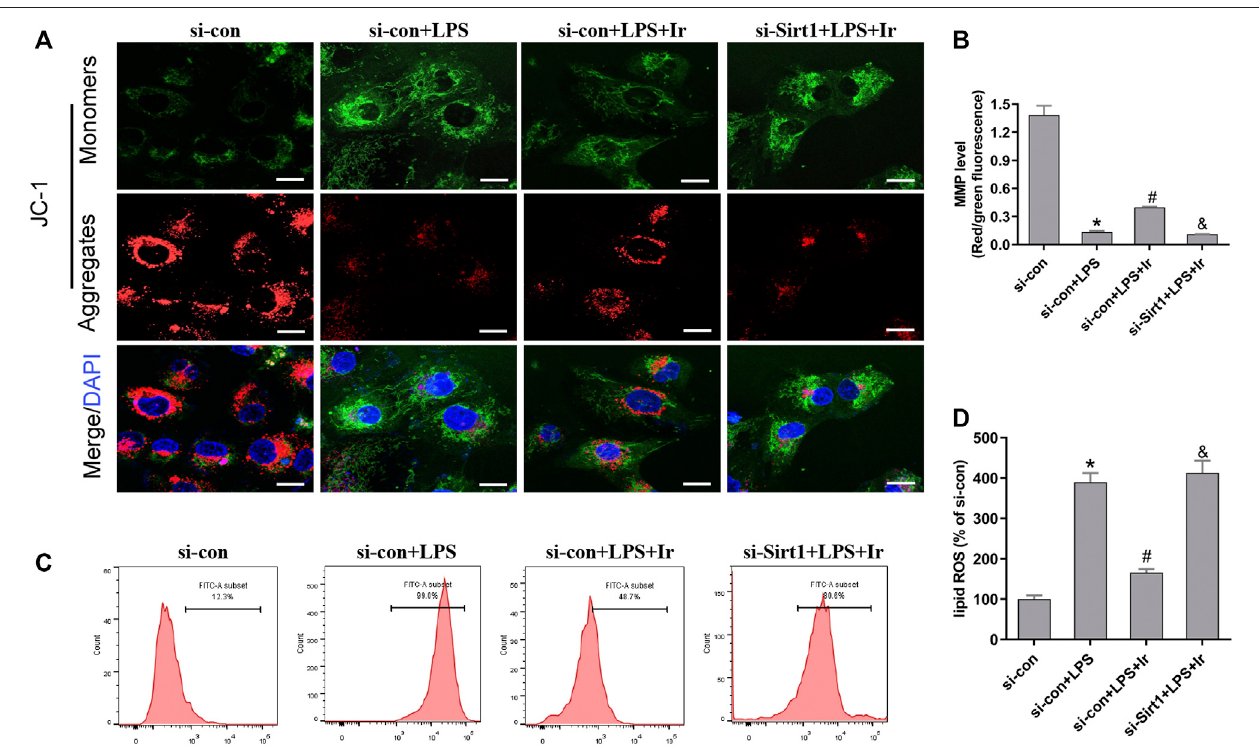
FIGURE 5 | Irisin inhibits LPS-induced accumulation ofROS and lipid peroxidation. (A) Fluorescence images of 5 μ M JC-1-stained HK-2 cells. Scale bars: 20 μ m. The ratio of red and green fl uorescence re fl ected changes of the mitochondrial membrane potential (MMP) ( n = 3). (B) Quantitative results of MMP. (C) lipid ROS was analyzedusing2 μ MBODIPY ® 581/591C11by fl owcytometry(n=5). (D) QuantitativeresultsoflipidROS(n=3).* p < 0.05vs.si-congroup, # p < 0.05vs.si-con+LPS group, & p < 0.05 vs. si-con + LPS + Ir group. Data are presented as mean ± SD ( n =